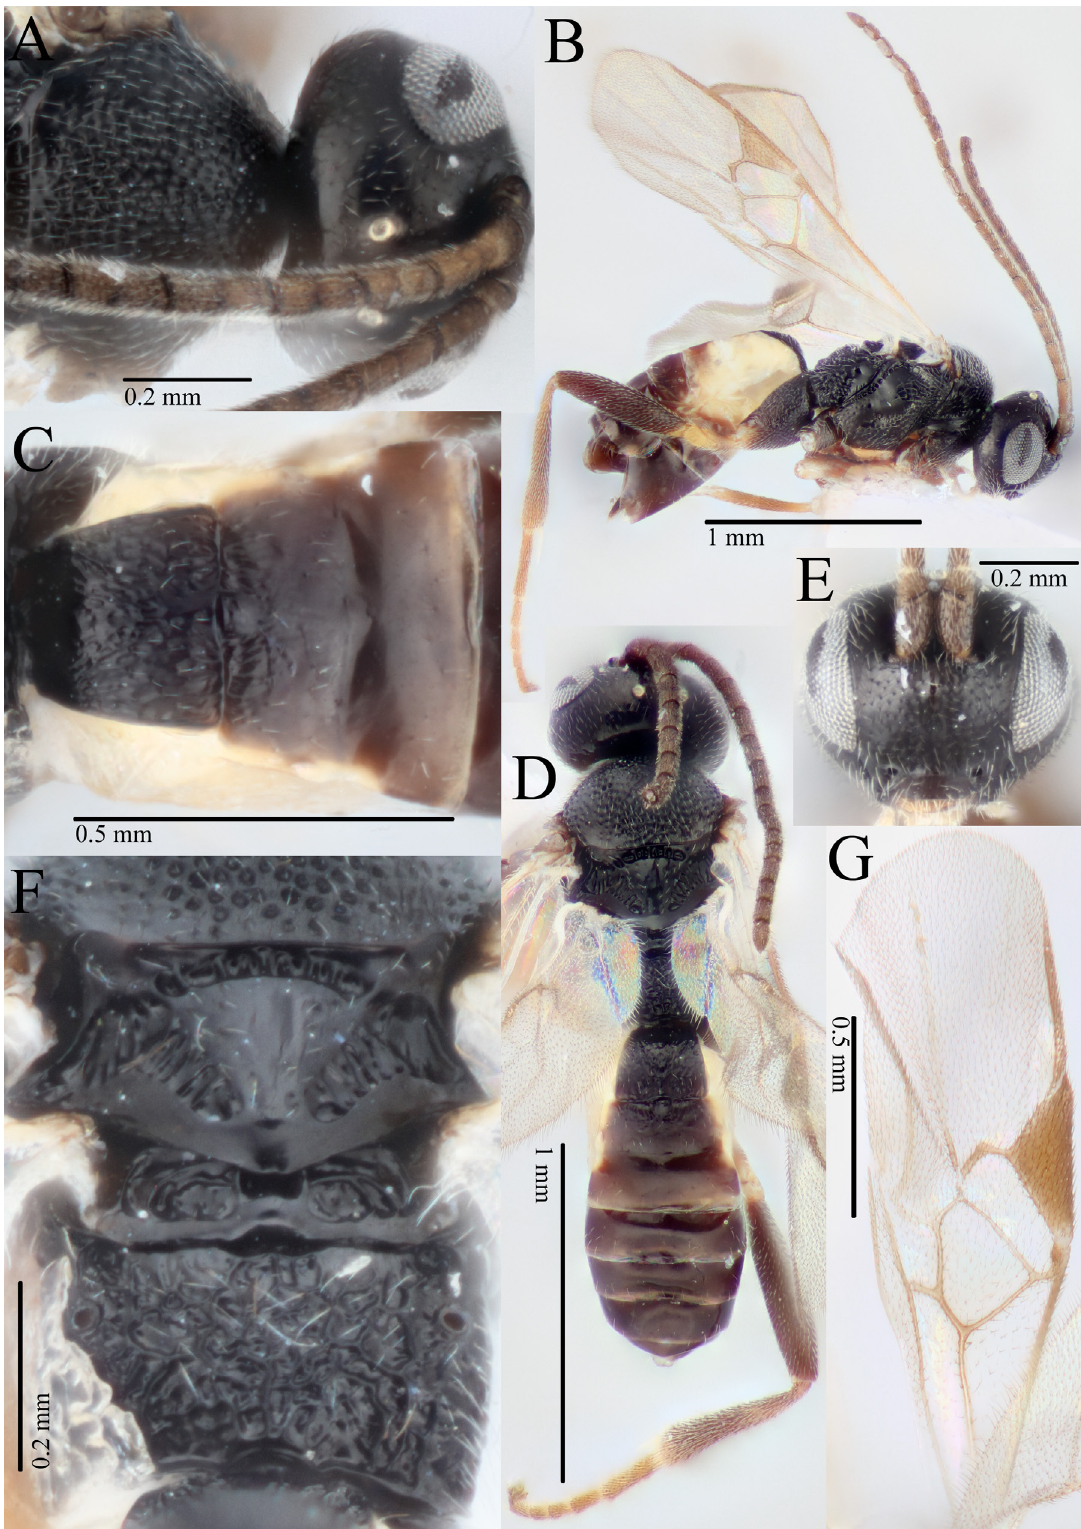
Fig. 22. Cotesia ocellata sp. nov., holotype, ♀ (SAMA 32-44404). A . Head in dorsal view and anteromesoscutum. B . Habitus in lateral view. C . T1–3. D . Habitus in dorsal view. E . Head in anterior view. F . Mesoscutum and propodeum. G . Fore